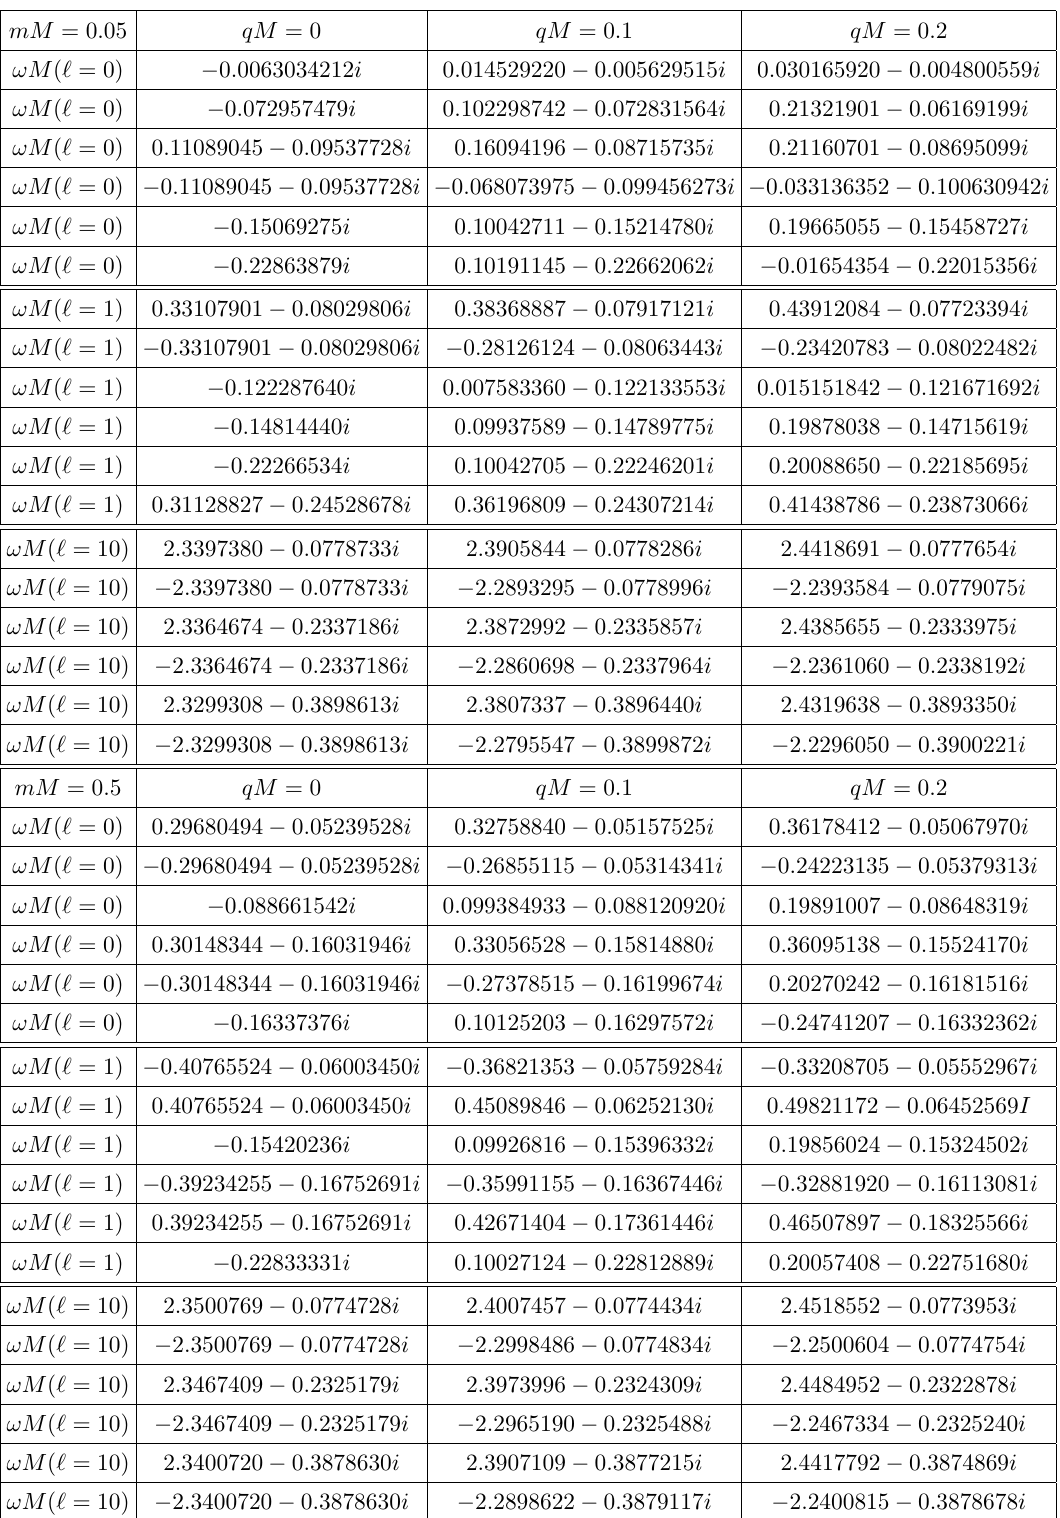
Table 16 . The QNFs ωM for massive scalar fields in the background of RNdS black holes with Λ M 2 = 0 . 04 , and different values of ‘ , and qM . Here, Q/M = 1 . 004 , ∆ r ≈ 0 . 163 , with ∆ r = r H − r C